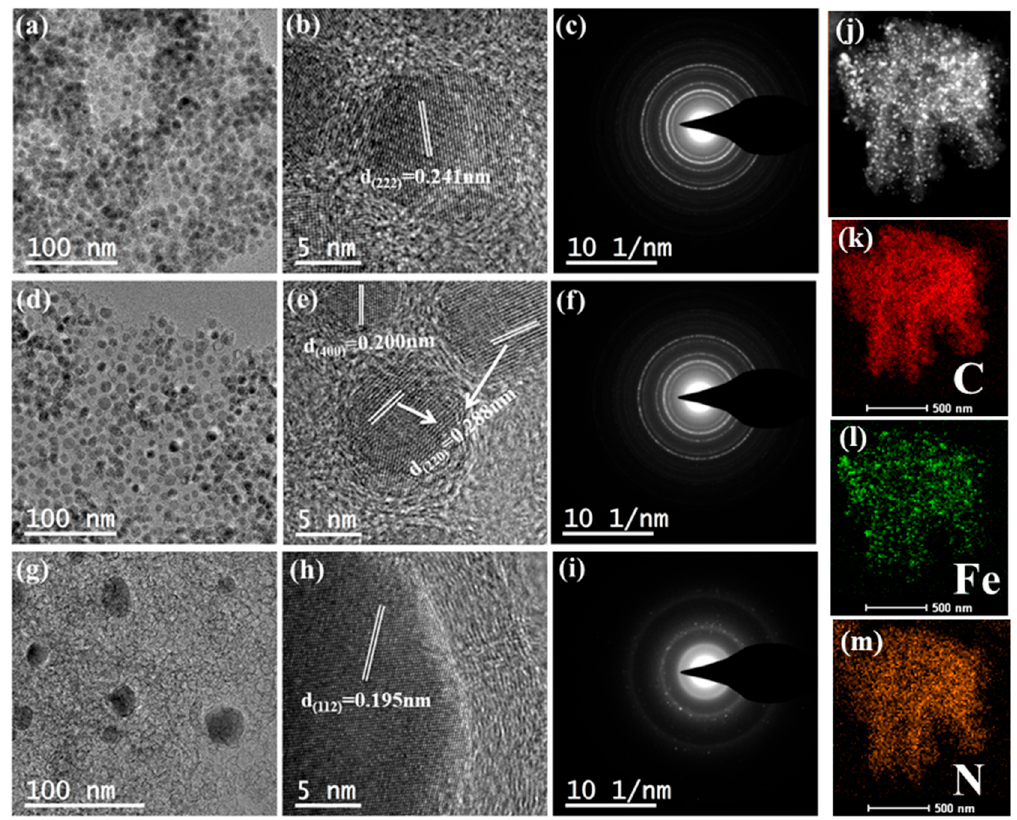
Figure 3. TEM images of ( a – c ) Fe 3 O 4 /rGO-100, ( d – f ) Fe 3 O 4 /rGO-H-100 and ( g – i ) N-Fe 3 C/rGO-H-100. ( j – m ) EDS mapping of C, Fe and N in N-Fe 3